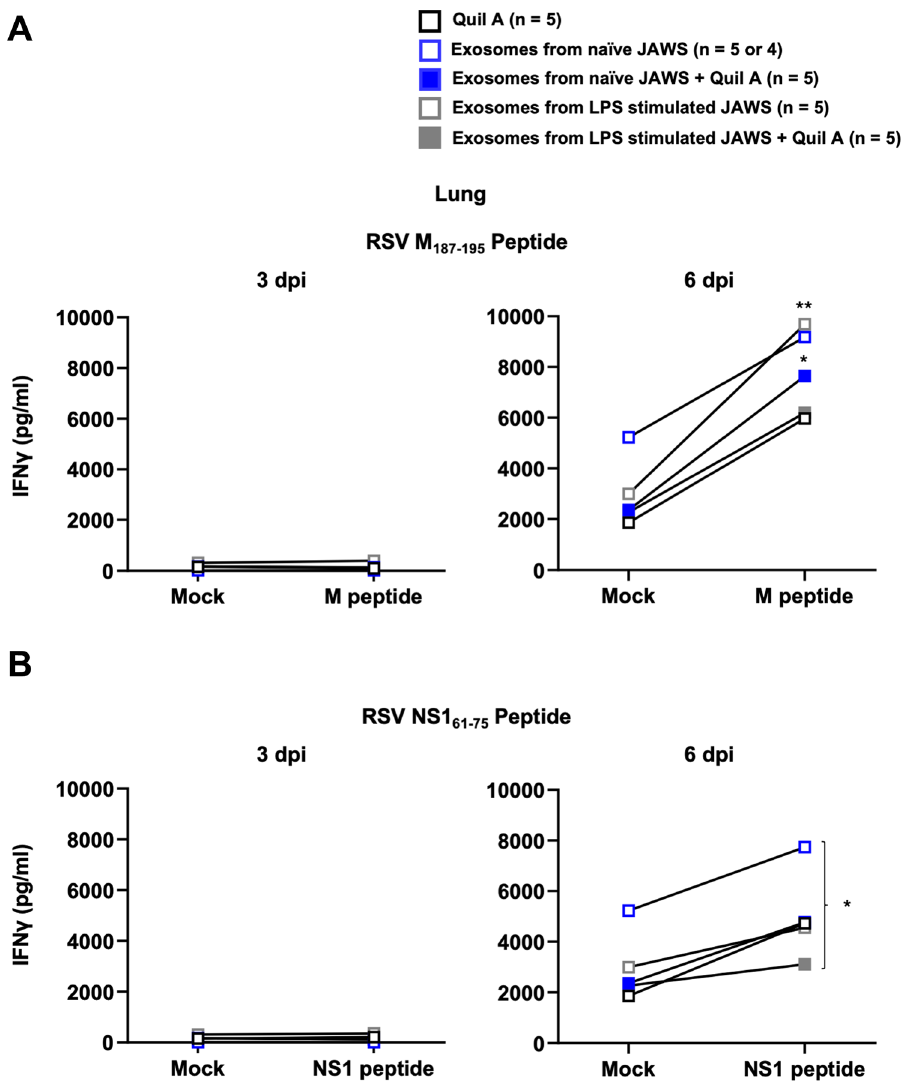
Figure 5. Vaccination with the surface engineered exosomes was not able to elicit exosome-induced memory T cell responses in vivo . Groups of vaccinated mice were sacrificed either 3 or 6 days post-infection (dpi). Cells from the lungs were stimulated with ( A ) M 187–195 or ( B ) NS1 61–75 peptides for 72 h. An ELISA analysis for IFN-γ was performed on the cell culture supernatants. Data are presented as means ± SEM. ( A ) *p < 0.05, **p < 0.01 as determined by two-way ANOVA and Šídák’s multiple comparisons test. ( B ) *p < 0.05 as determined by two-way ANOVA and Tukey’s multiple comparisons